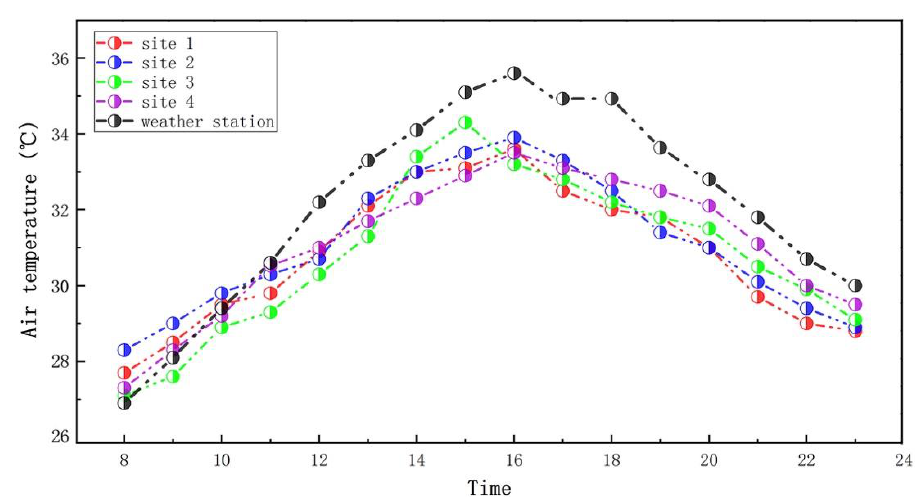
Figure 3. Air-temperature trends between measurement and weather station from 8:00 to 23:00 on 21 July 2018.